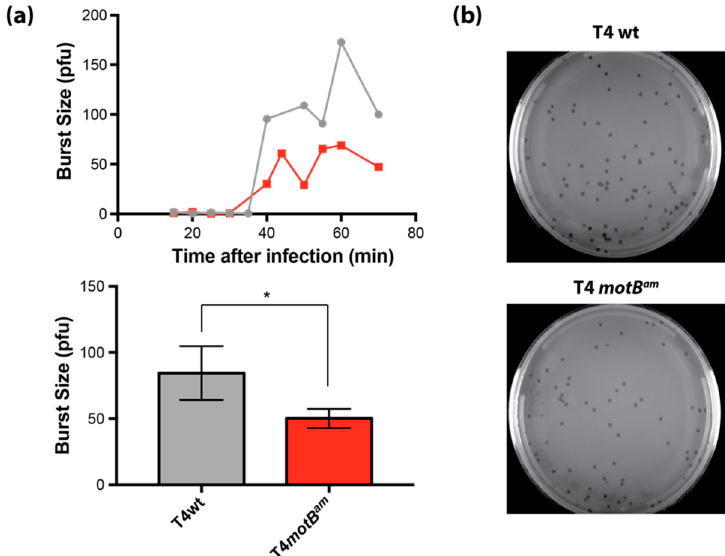
Figure 7. MotB improves the burst size of a T4 infection, but has no obvious effect on plaque size. ( a ) A motB knock-down (T4 motB am , red) reduces burst size approximately twofold compared to a wild- type infection (T4 wt, grey). Top panel shows burst size as determined by plaque forming units (pfu) over the time course of a T4 infection for a representative set of infections. Bottom panel shows a bar graph of the average burst size with standard deviations determined for three independent replicates. The asterisk (*) indicates significance as determined by an unpaired t -test with a p value ≤ 0.05. ( b ) A motB knock down ( motB am ) does not affect plaque size. Representative image of plaques formed using T4 wt (top panel) or T4 motB am (bottom panel). Images are representative of at least three independent replicates.